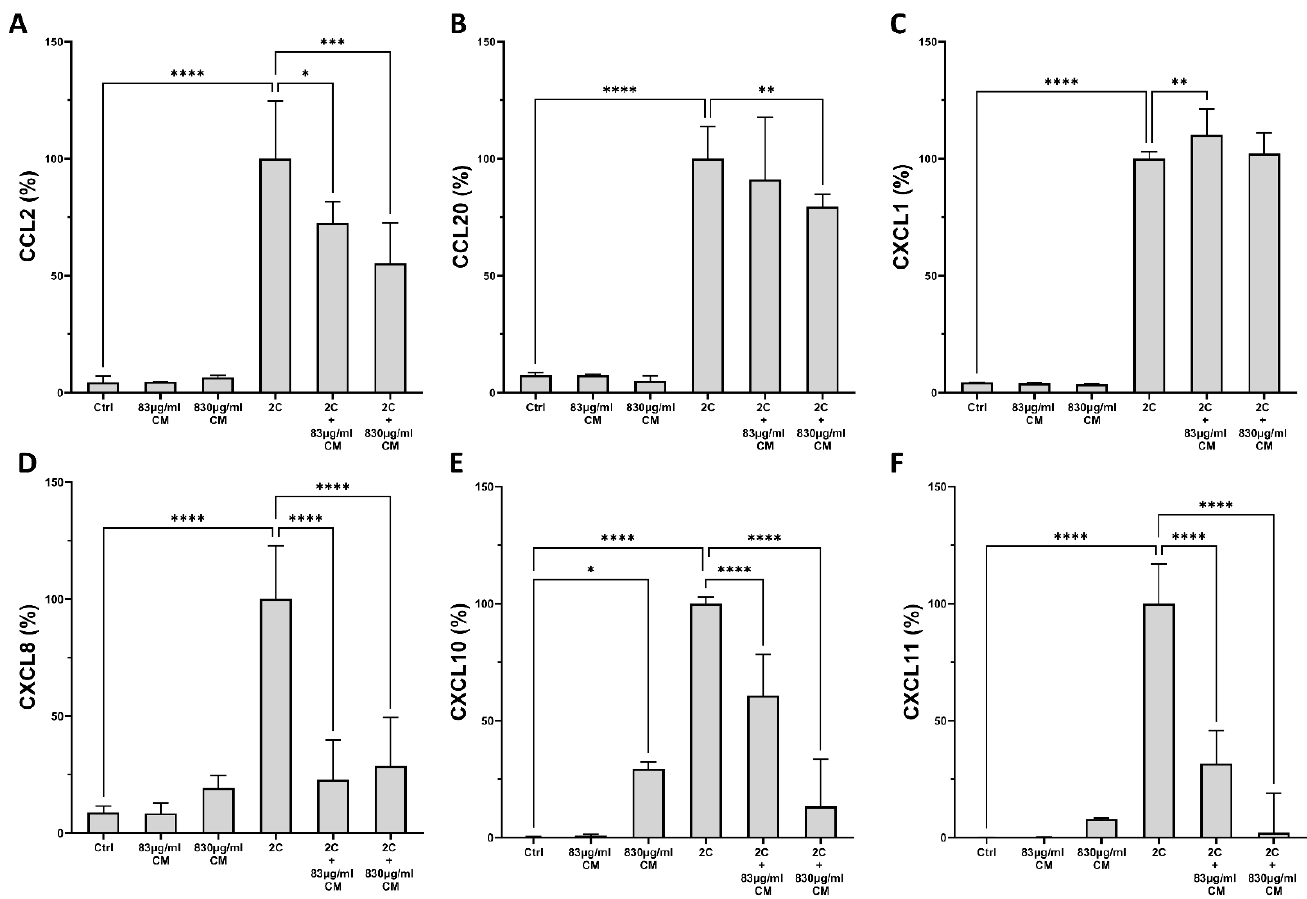
Figure 3. The effect of CM on chemokine protein expression in Α 549 epithelial cells, which are under pro-inflammatory stimuli. The CM inhibit the protein expression of chemokines CCL2 ( A ), CCL20 ( B ), CXCL8 ( D ), CXCL10 ( E ) and CXCL11 ( F ) in a dose-dependent way, but have no effect on the